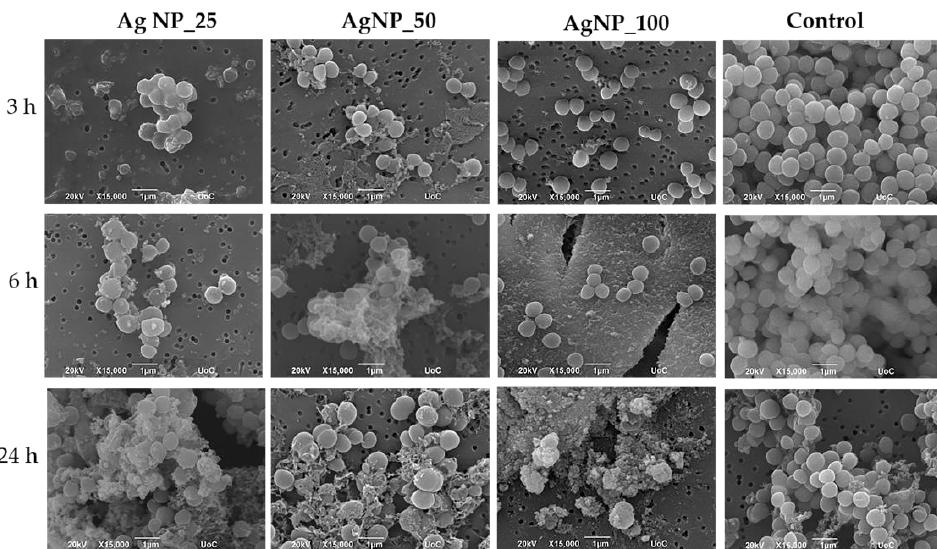
Figure 4. Representative SEM images showing the induction of 100 ppm AgNPs on S. aureus for 3, 6, and 24 h. The control represents the morphology of the bacteria without AgNPs. Magnification is 15,000× and scale bar represents 1 μm.